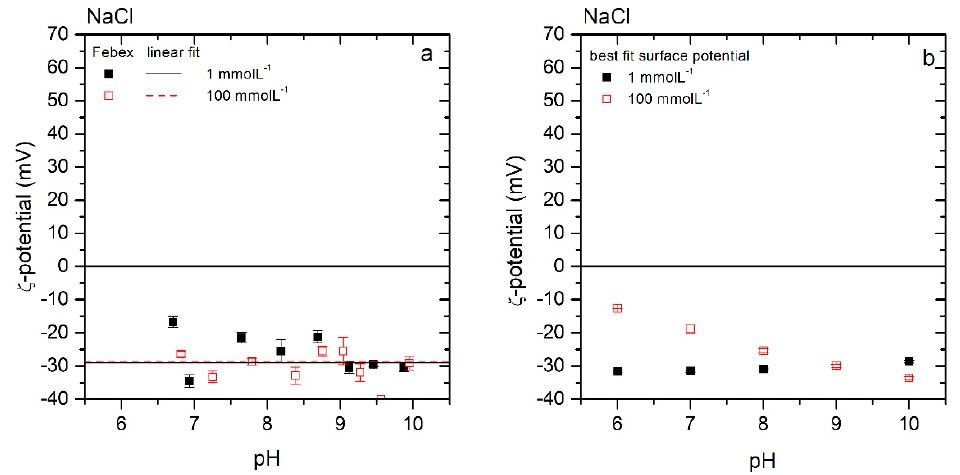
Figure 6. FEBEX bentonite colloid ζ -potential in NaCl electrolyte solution ( a ). Data points represent the measured ζ -potential at 1 mmol · L − 1 (filled squares) and 100 mmol · L − 1 (open squares). The lines indicate the linearly fitted pH and ionic-strength independent surface potential, as indicated in Table S2. The symbols in ( b ) represent the best fit for the surface electrokinetic potential to recalculate the observed stability ratio given in Table 2. The value of the surface electrokinetic potential is given in Table S6.